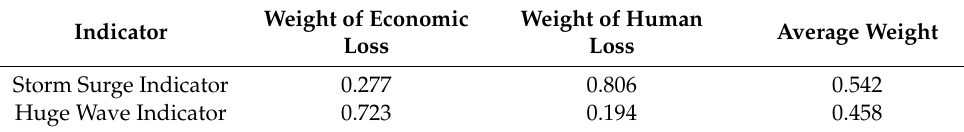
Table 2. Weights of storm surge and huge wave indicators calculated with the entropy method. Weight of Economic Indicator Loss Storm Surge